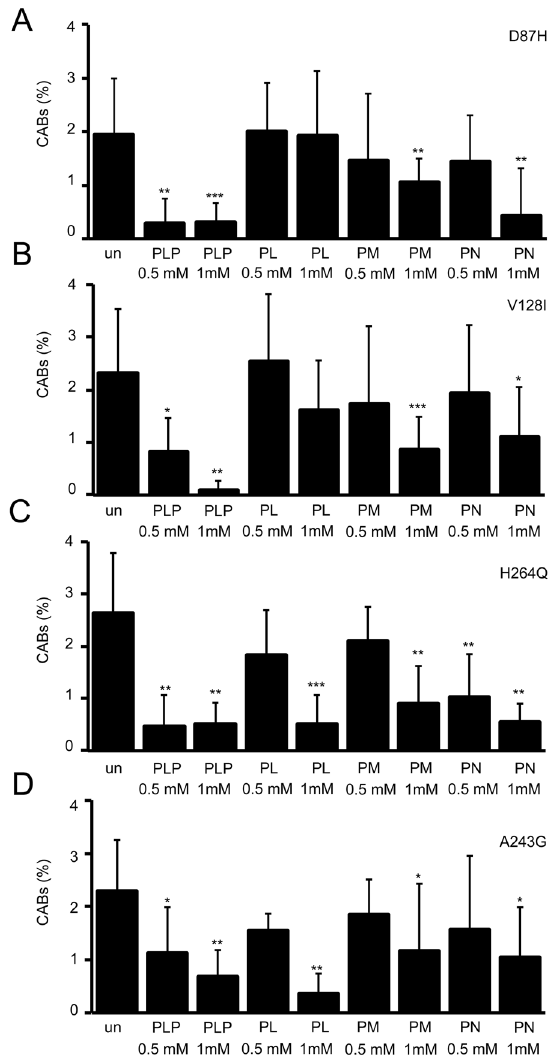
Figure 4. Effect of PLP precursors (PL, PM and PN) on CAB frequency in brains from larvae expressing D87H (A) , V128I (B) , H246Q (C) and A243G (D) variants. Each bar represents the mean value ± SD obtained by scoring at least 8 brains ( ∼ 1000 cells) for genotype. * , ** , *** Significantly different in the Student’s t test with p < 0.05, 0.01 and 0.001 respectively.